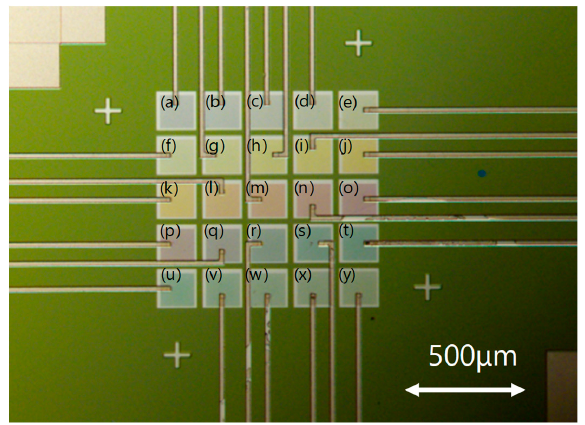
Figure 8. Optical microphotographs of fabricated color filters on the photodiode array. ( a ) Λ = 220 nm, ( b ) Λ = 230 nm, ( c ) Λ = 240 nm, ( d ) Λ = 250 nm, ( e ) Λ = 260 nm, ( f ) Λ = 270 nm, ( g ) Λ = 280 nm, ( h ) Λ = 290 nm, ( i ) Λ = 300 nm, ( j ) Λ = 310 nm, ( k ) Λ = 320 nm, ( l ) Λ = 330 nm, ( m ) Λ = 340 nm, ( n ) Λ = 350 nm,